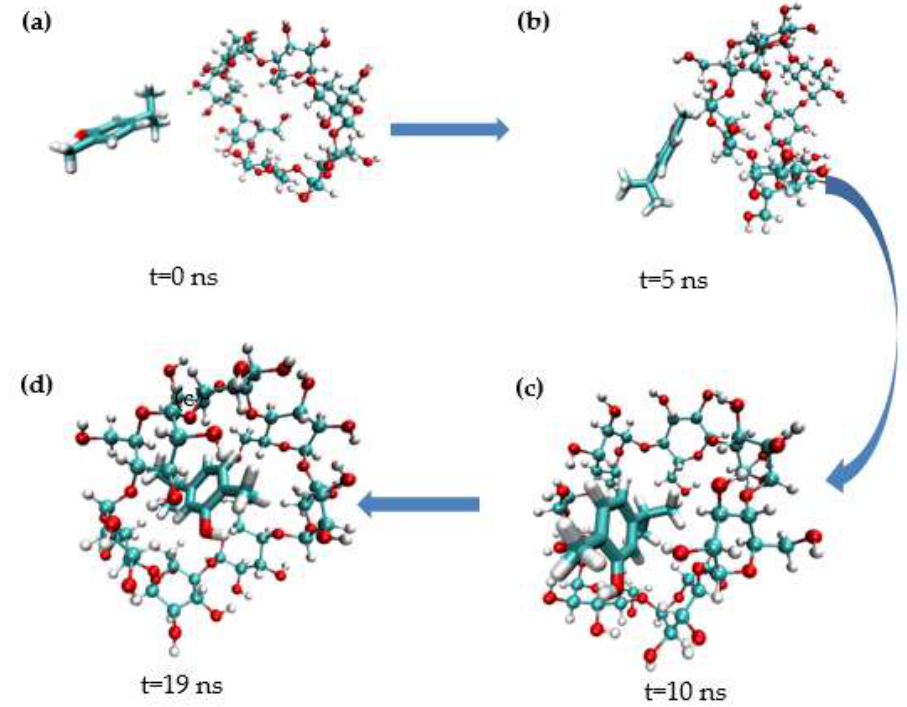
Figure 9. Representative images from carvacrol and β − CD simulation. ( a ) t = 0 ns; ( b ) t = 5 ns; ( c ) t = 10 ns; ( d ) t = 19 ns.